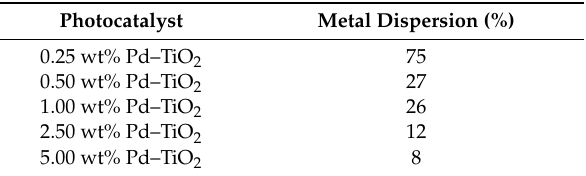
Table 2. Metal Dispersion on TiO 2 Photocatalysts.